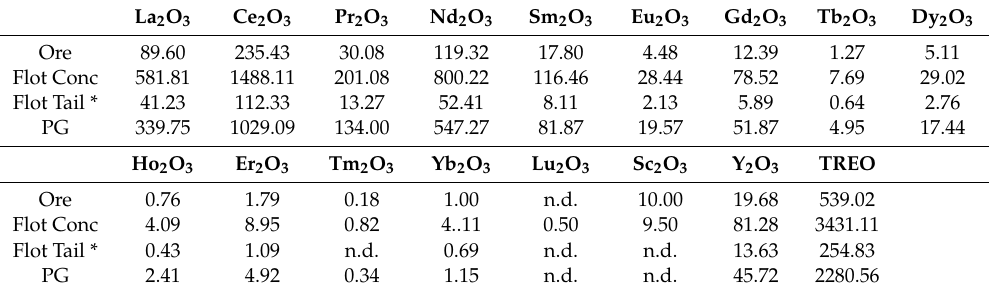
Table 4. The individual REEs concentrations of the ore, concentrate and PG by ICP-MS (mg/kg).